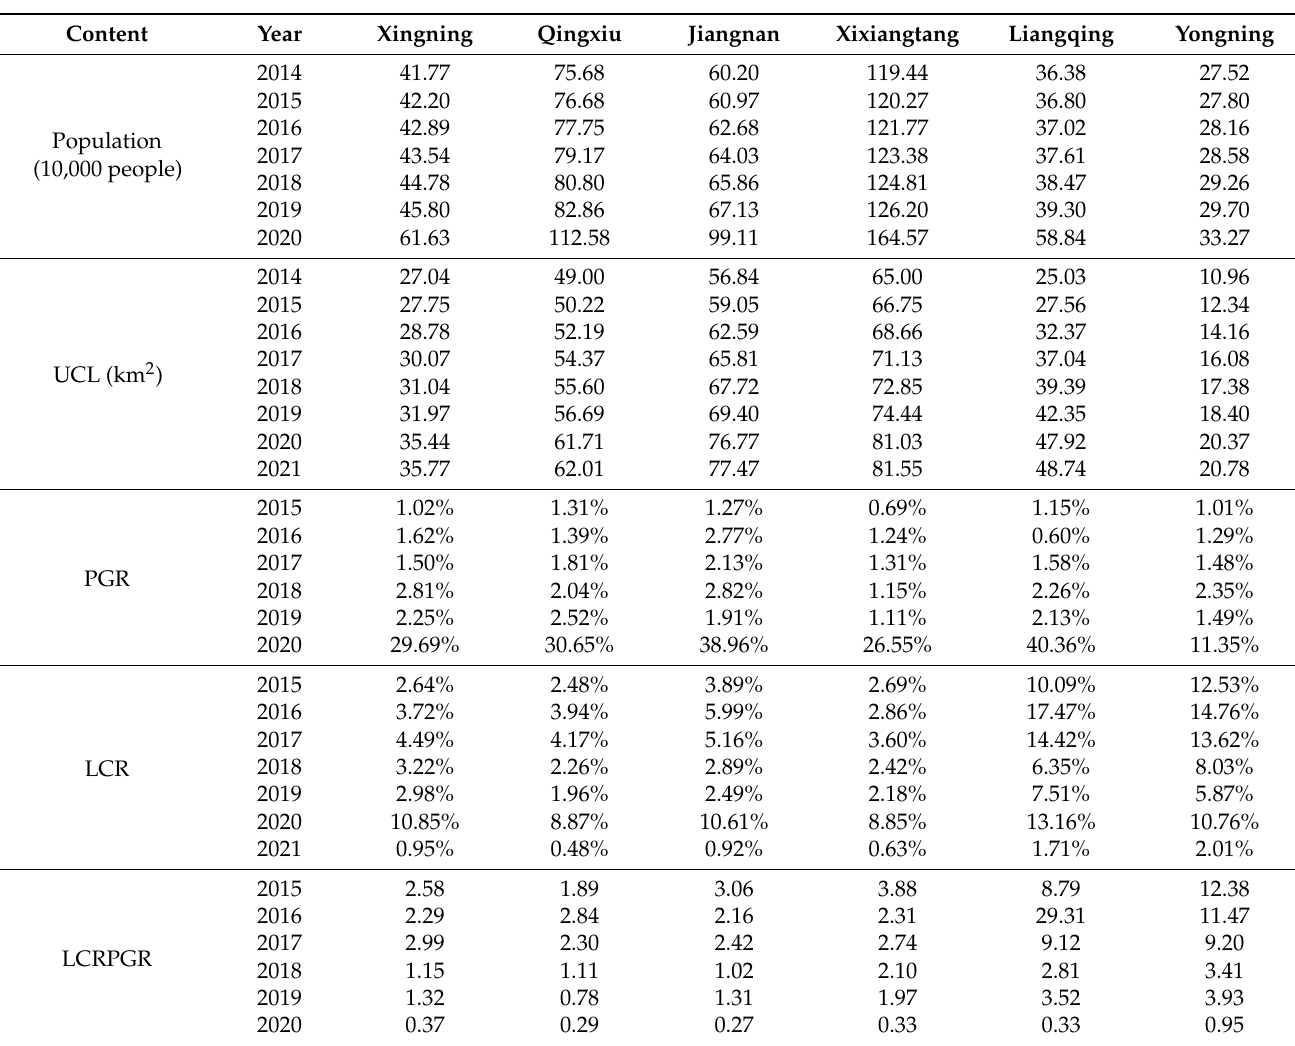
Table A2. Data of population, construction land, and sustainable development in various districts of